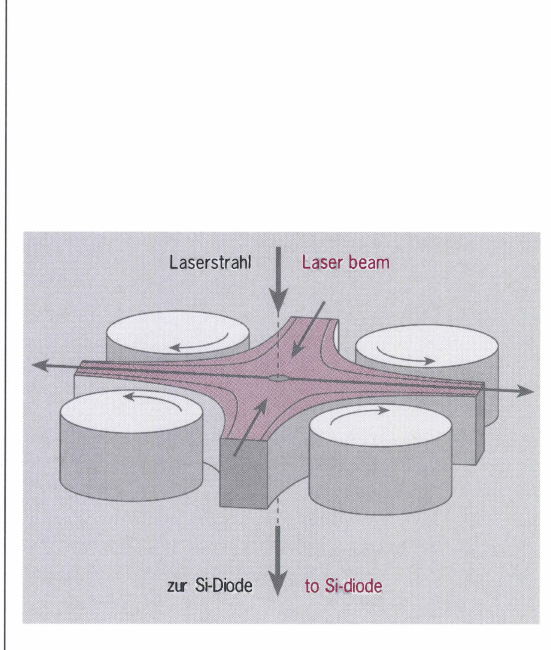
Fig. 2: 1/ustration of planar extensional flow lines in the center of a four roll mill used to conduct optical measurements at the point of